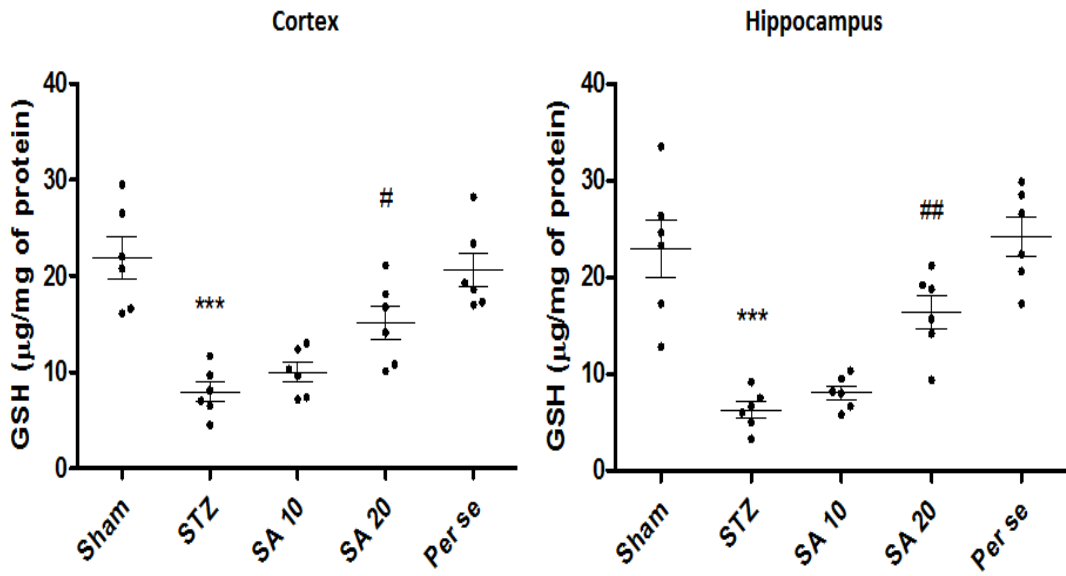
Figure 5. E ff ect of sinapic acid on brain GSH levels in the cortex and hippocampus. Data are presented as mean ± SEM, ( n = 6). * as compared to the sham group, # as compared to the STZ group. *** p < 0.001, # p < 0.05, ## p < 0.01. STZ—Streptozotocin, SA—Sinapic